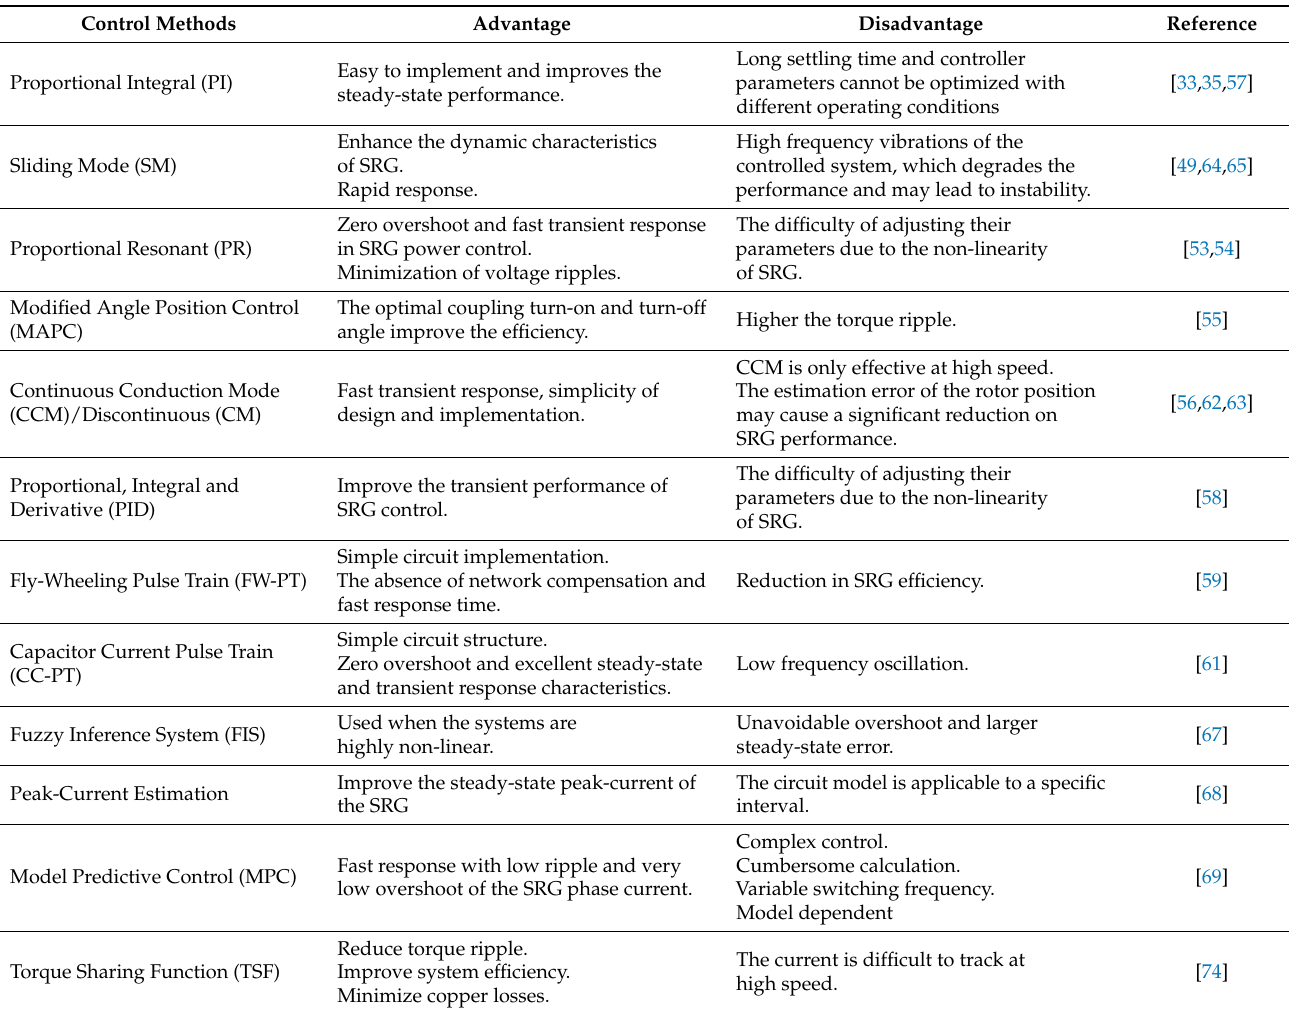
Figure 19. Torque Sharing Function (TSF) control scheme. Table 3. Comparison of different SRG control